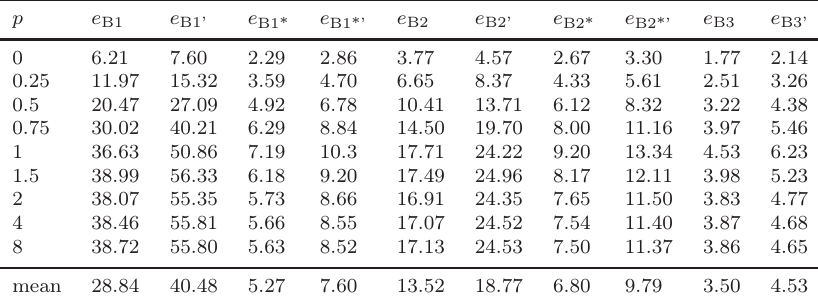
Table 2. Means of error ratios for balancing